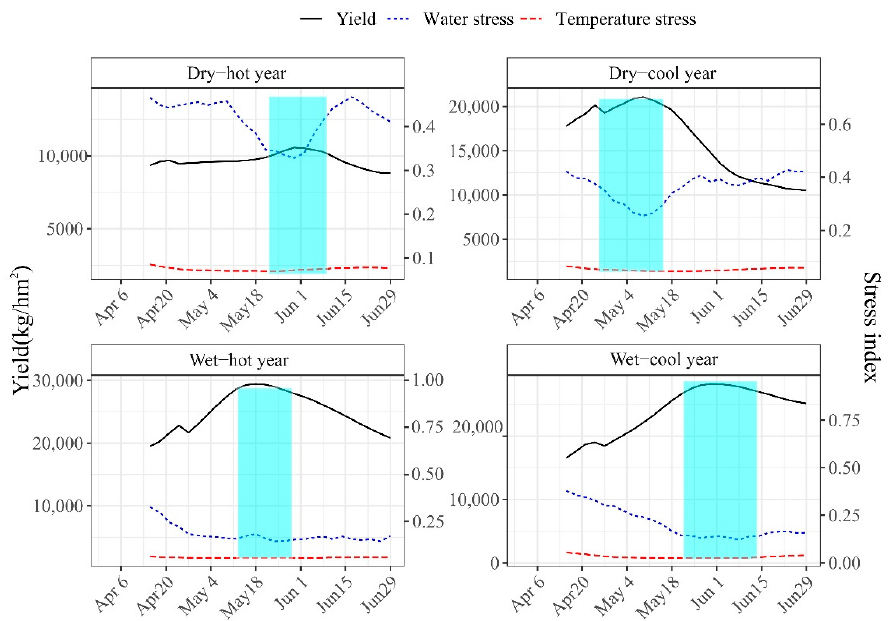
Figure 3. Example of the relationship between average simulated water-limited yield and planting dates for a rapidly developing cultivar (Favorita) in different water-temperature year types at ZLTQ. The blue dashed line indicates the average water stress during the early tuber phase, the red dashed line shows the average temperature stress in the potato growing season, and the cyan rec- tangle zone represents the optimal planting period at which yield >95% of the running peak mean yield in different water-temperature year types.